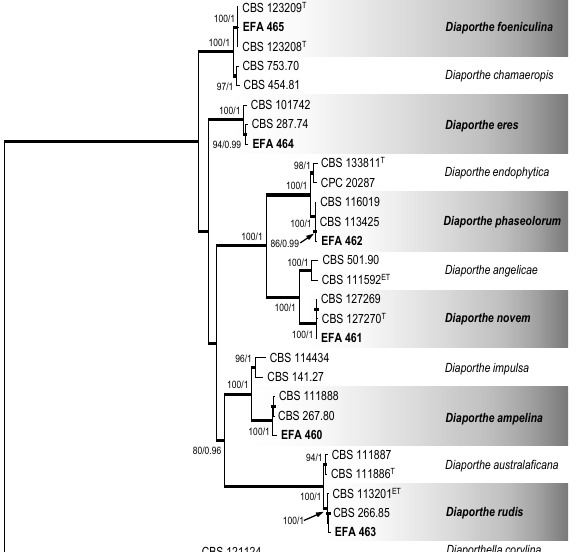
Figure 5. Phylogram generated from Maximum Likeli- hood analyses of Botryosphaeriaceae species isolated in this study and their closely related species based on com- bined ITS, LSU, his3 , tef1 and tub2 sequence data. Thickened branches are those present in both the maximum likelihood and Bayesian inference trees. Bayesian posterior probabili- ties ≥0.90 and bootstrap support values for ML ≥70% are indicated at the nodes. The tree was rooted to Saccharata proteae (CBS 115206). Isolates generated in this study are in bold, ex-type reference strains are indicated with T and ex- epitype reference strains with ET . The scale bar represents the expected changes per